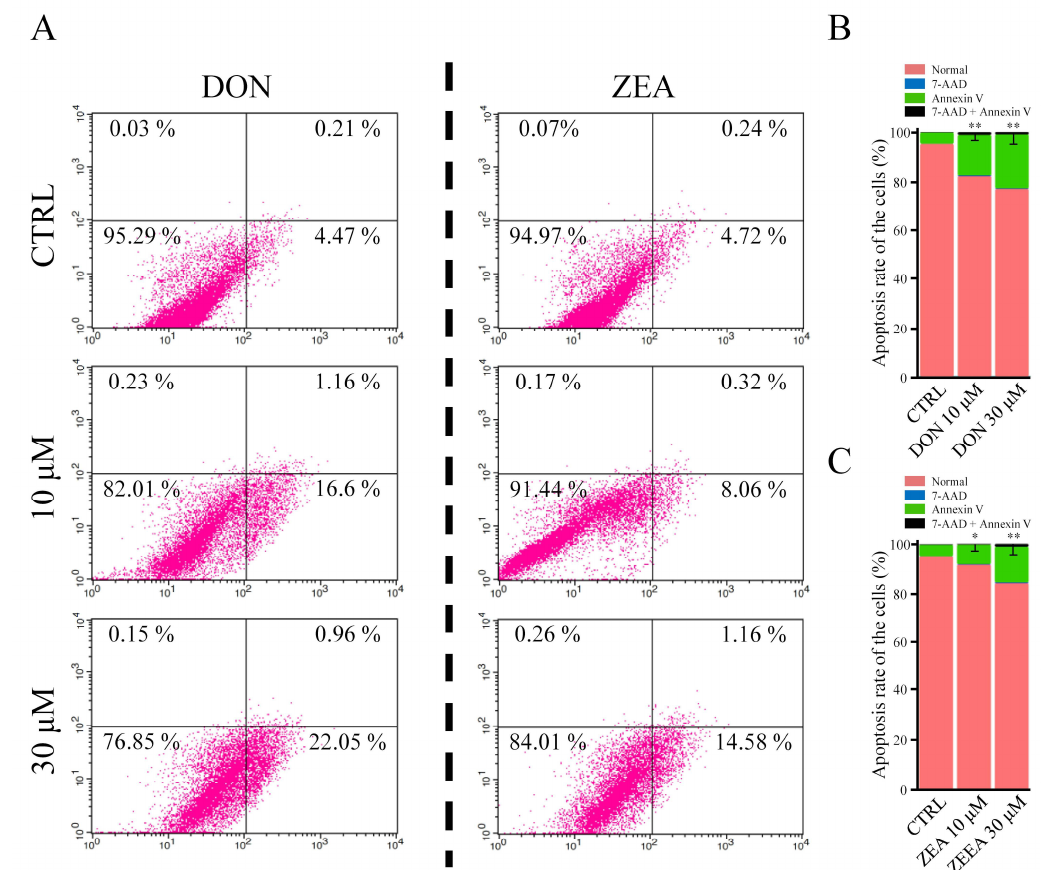
Figure 2. The effect of DON and ZEA on SCs apoptosis, analysed by flow cytometry. ( A ) The apoptosis results of SCs following administration of 0 µ M, 10 µ M, and 30 µ M DON and ZEA after 72 h of culture in vitro. ( B ) The apoptosis rate of SCs after 0 µ M, 10 µ M, and 30 µ M DON treatment. ** p < 0.01. ( C ) The apoptosis rates of SCs after exposure to 0 µ M, 10 µ M, and 30 µ M ZEA treatment. * p < 0.05; ** p <